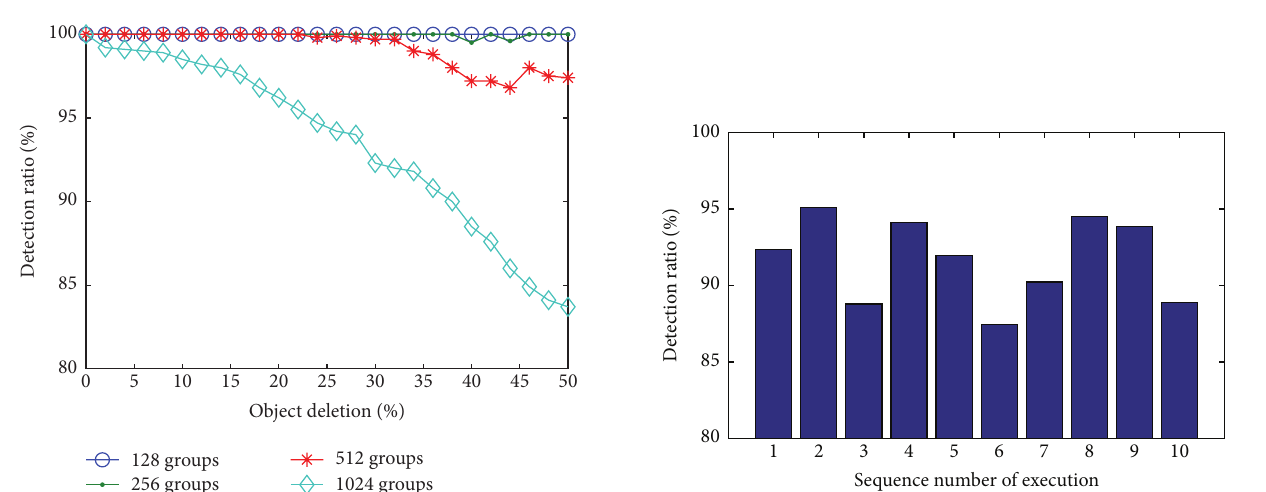
Figure 5: Resistance to object deletion.